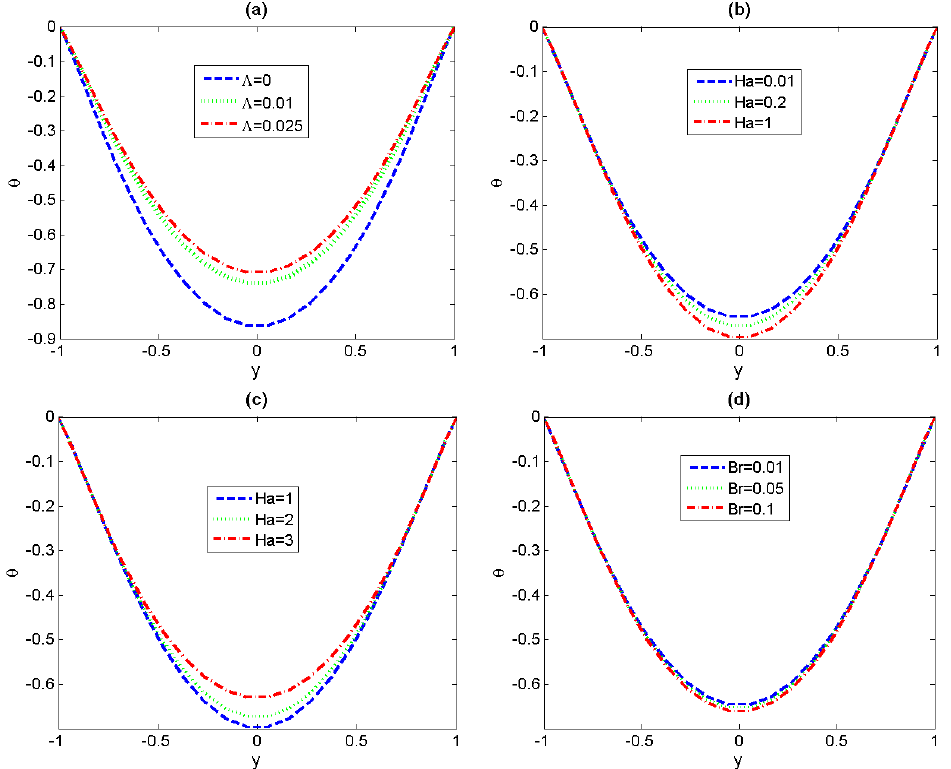
Figure 6. Variations of temperature for different fluid physical parameters. ( a ) S = 1, Ω = 0, Ha = 0.1, Br = 0.1; ( b , c ) Λ = 0.5, S = 1, Ω = 0, Br = 0.1; ( d ) Λ = 0.5, Ha = 1, Ω = 0, S = 1.